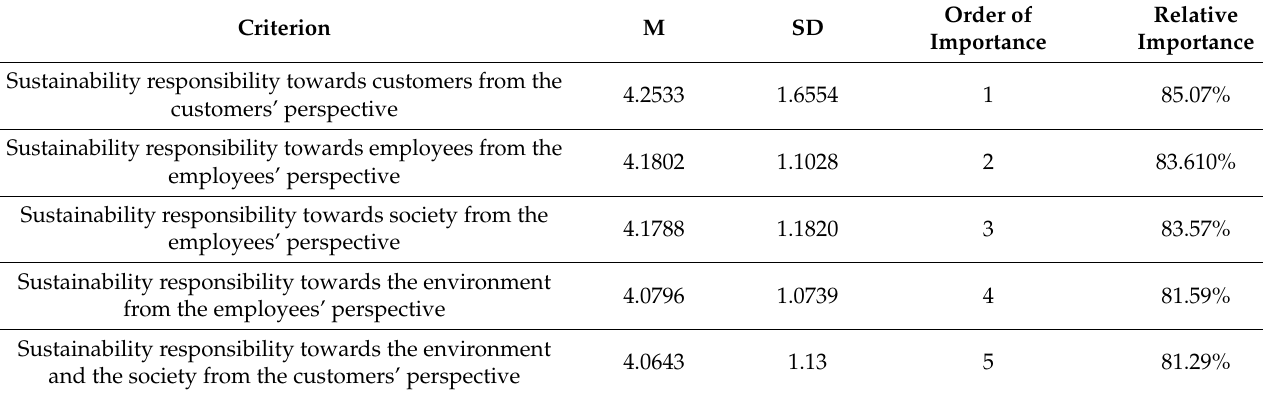
Table 2. Ranking sustainability responsibility criteria by relative importance.